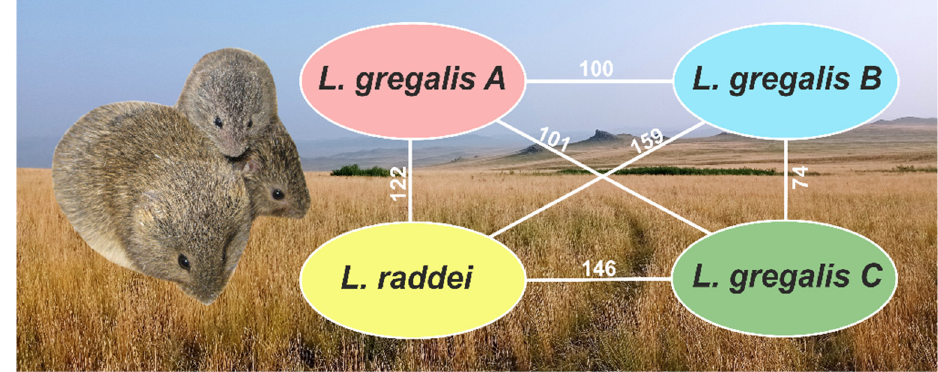
Figure 3. The number of genes with contrasting SNPs between the compared groups. Table 1. The list of genes that could potentially be related to speciation processes found when comparing L. gregalis and L. raddei